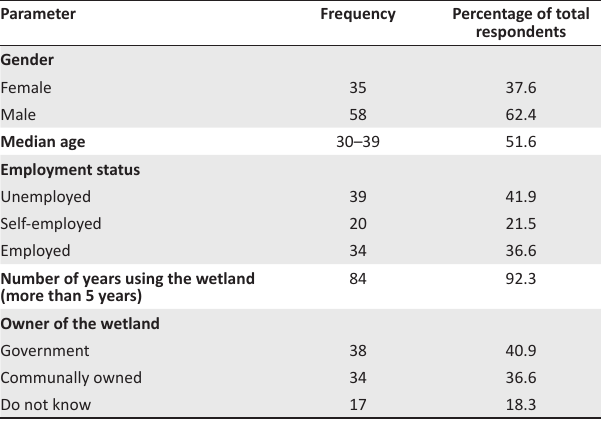
TABLE 1: Summary of the demographic background of communal wetlands respondents.